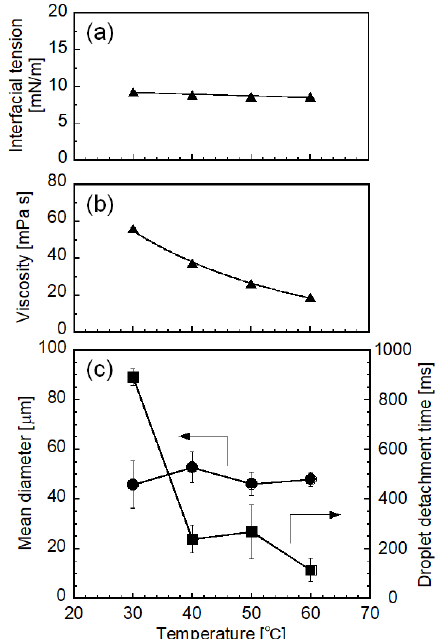
Figure 4. Effects of emulsification temperature on ( a ) interfacial tension (triangles), ( b ) viscosity of to-be-dispersed palm oil (triangles), and ( c ) d m (circles) and droplet detachment time (squares) in the MC emulsification with MC-A using 3 wt% SC as an emulsifier. Error bars ( c ) denote standard deviations.